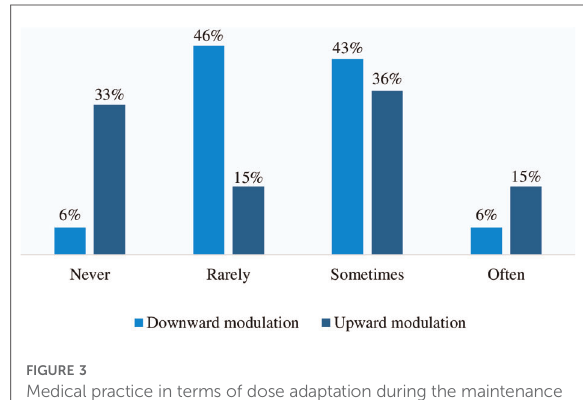
FIGURE 3 Medical practice in terms of dose adaptation during the maintenance phase as reported by the respondent physicians ( n =33).